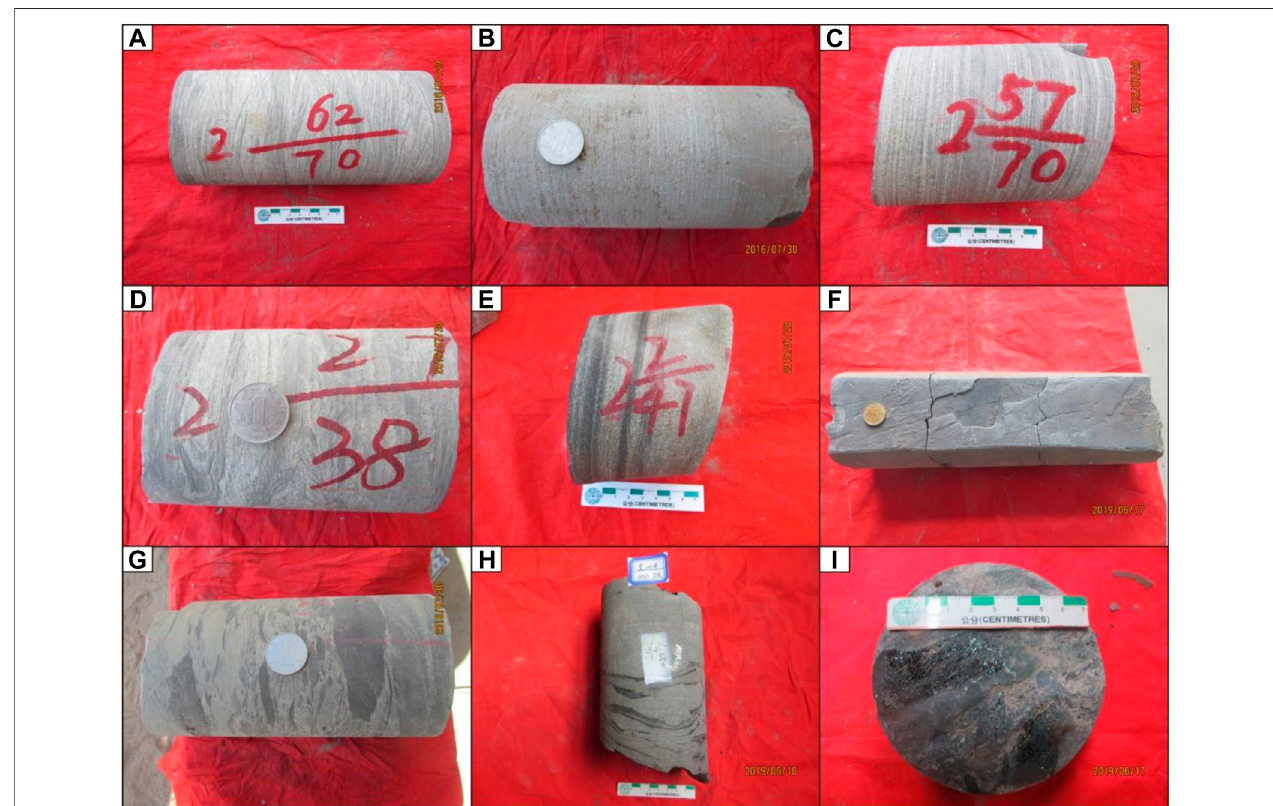
FIGURE3| CorephotosofYangchangformationinstudyarea. (A) Crossbedding; (B) Massivebedding; (C) Parallelbedding; (D) Convolutedbedding; (E) Oblique bedding; (F) Fractures; (G) Mud gravel; (H) Muddy strip; (I) Scratch.